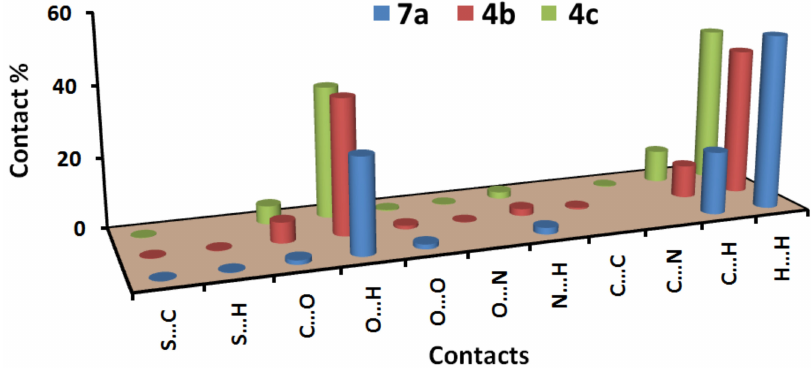
Figure 6. Quantification of the intermolecular interactions in the studied